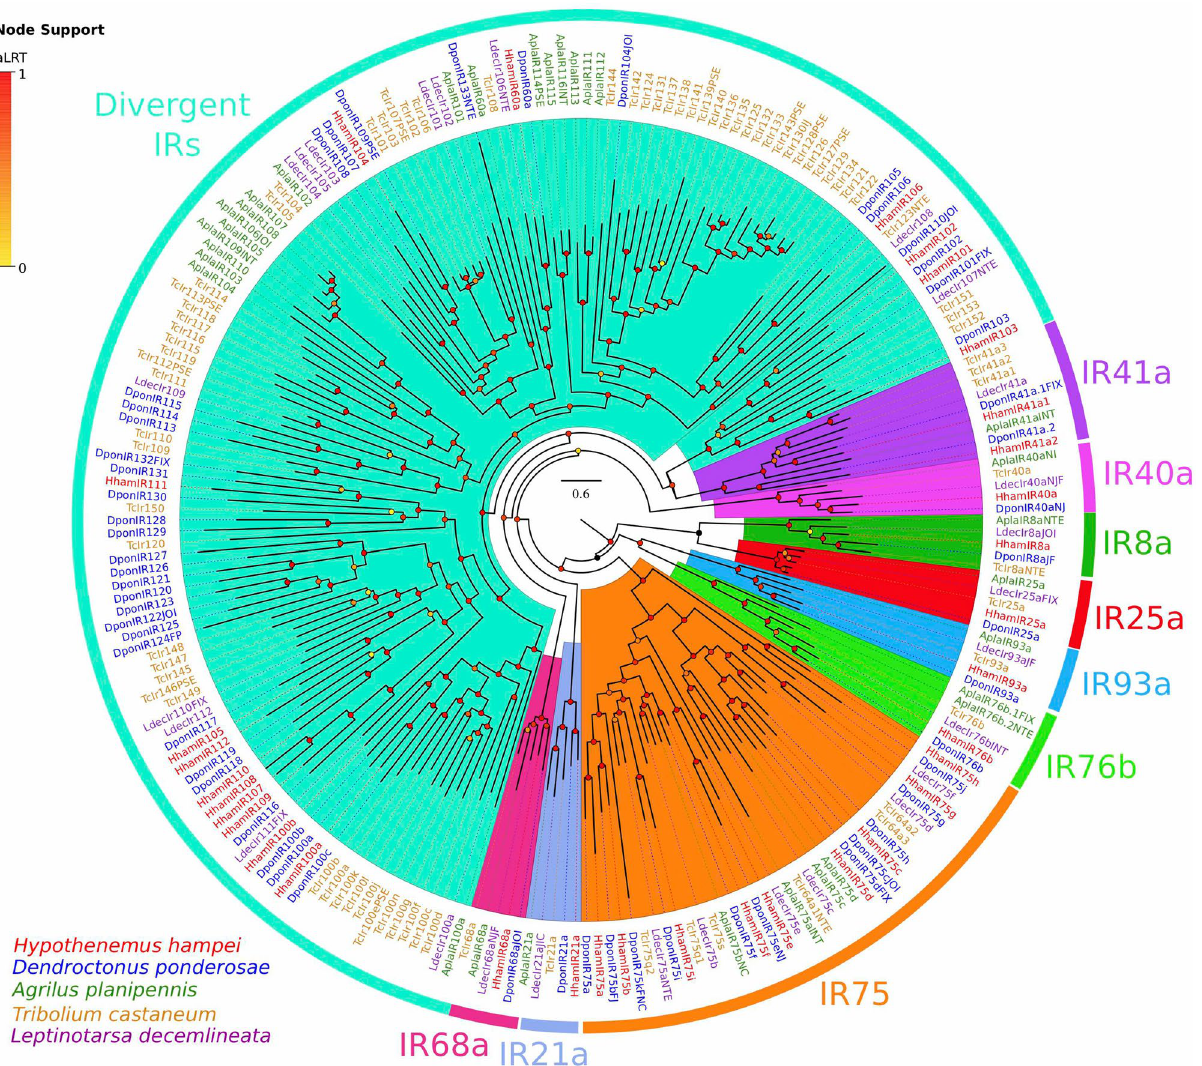
Figure 4. Phylogeny of ionotropic receptors (IR) family. IR protein sequences from Hypothenemus hampei (HhamIR), Dendroctonus ponderosae (DponIR), Agrilus planipennis (AplaIR), Tribolium castaneum (TcIr) and Leptinotarsa decemlineata (LdecIr) were clustered by Maximum-Likelihood tree-building. Branch supports (aLRT; approximate likelihood ratio test) are shown as colored circles (yellow to red transition). Colored arcs indicate the widely conserved lineages of antennal IRs (IR8a, IR25a, IR21a, IR40a, IR41a, IR68a, IR75 and IR76b) and the Divergent IR ( HhamGR1 / 2 / 10 ) are clustered within the carbon dioxide (CO 2 ) receptor clade and appear to be orthologous to DponGR2 , DponGR1 and DponGR3 , respectively, while HhamGR4 was placed within the conserved fructose receptor clade. The remaining HhamGRs are putative bitter-taste GRs forming separate clades between the Scolytinae species and A. planipennis , except for the recently discovered “GR215 clade” 40 that clustered single GR members from each species. Among the putative bitter-taste GRs there are two likely gene expansions in H. hampei involving 14 and 19 HhamGRs , respectively (indicated by a black arc in Fig. 3), however; the ecological relevance of these HhamGR gene expansions will need further investigation. So far, the most comprehensive gene annotations for GR repertoires in Scolytinae beetles are found for D. ponderosae (49 DponGR genes) and the annotation presented here for H. hampei (62 HhamGR genes). In perspective with the GR content in other Coleoptera species such as T. castaneum (207 GRs) 48 , Leptinotarsa decemlineata (144 GRs) 49 , and A. glabripen- nis (234 GRs) 50 , the number of GRs in H. hampei and D. ponderosae is strongly reduced. Whether or not the